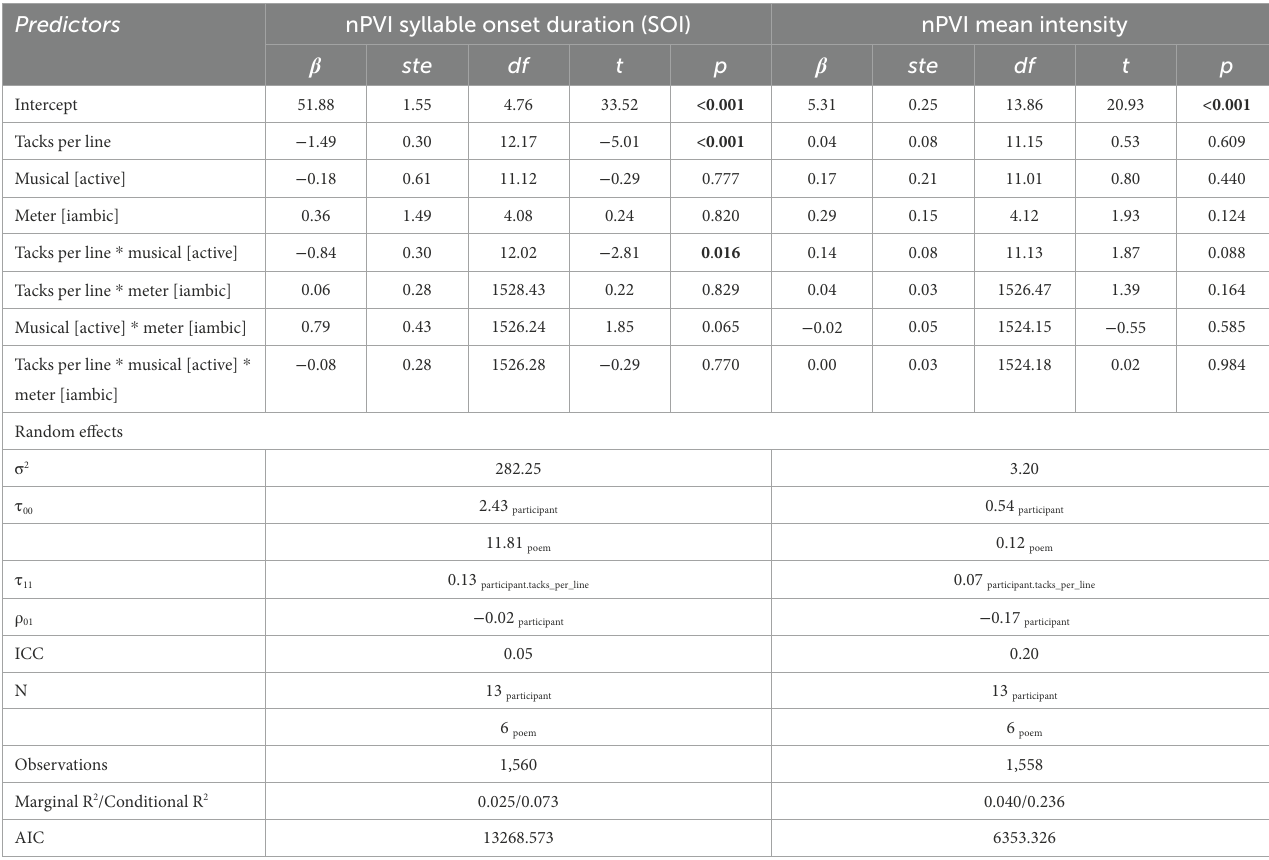
TABLE 4 Combined table for nPVI mean intensity and nPVI SOI for tack count.